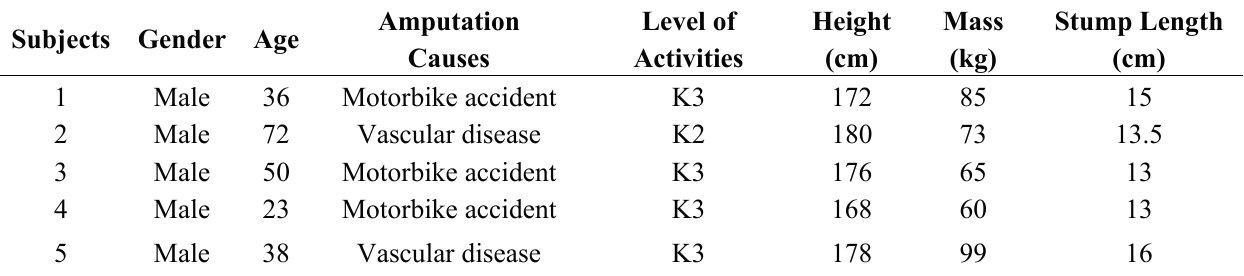
Table 1. Demographics of the